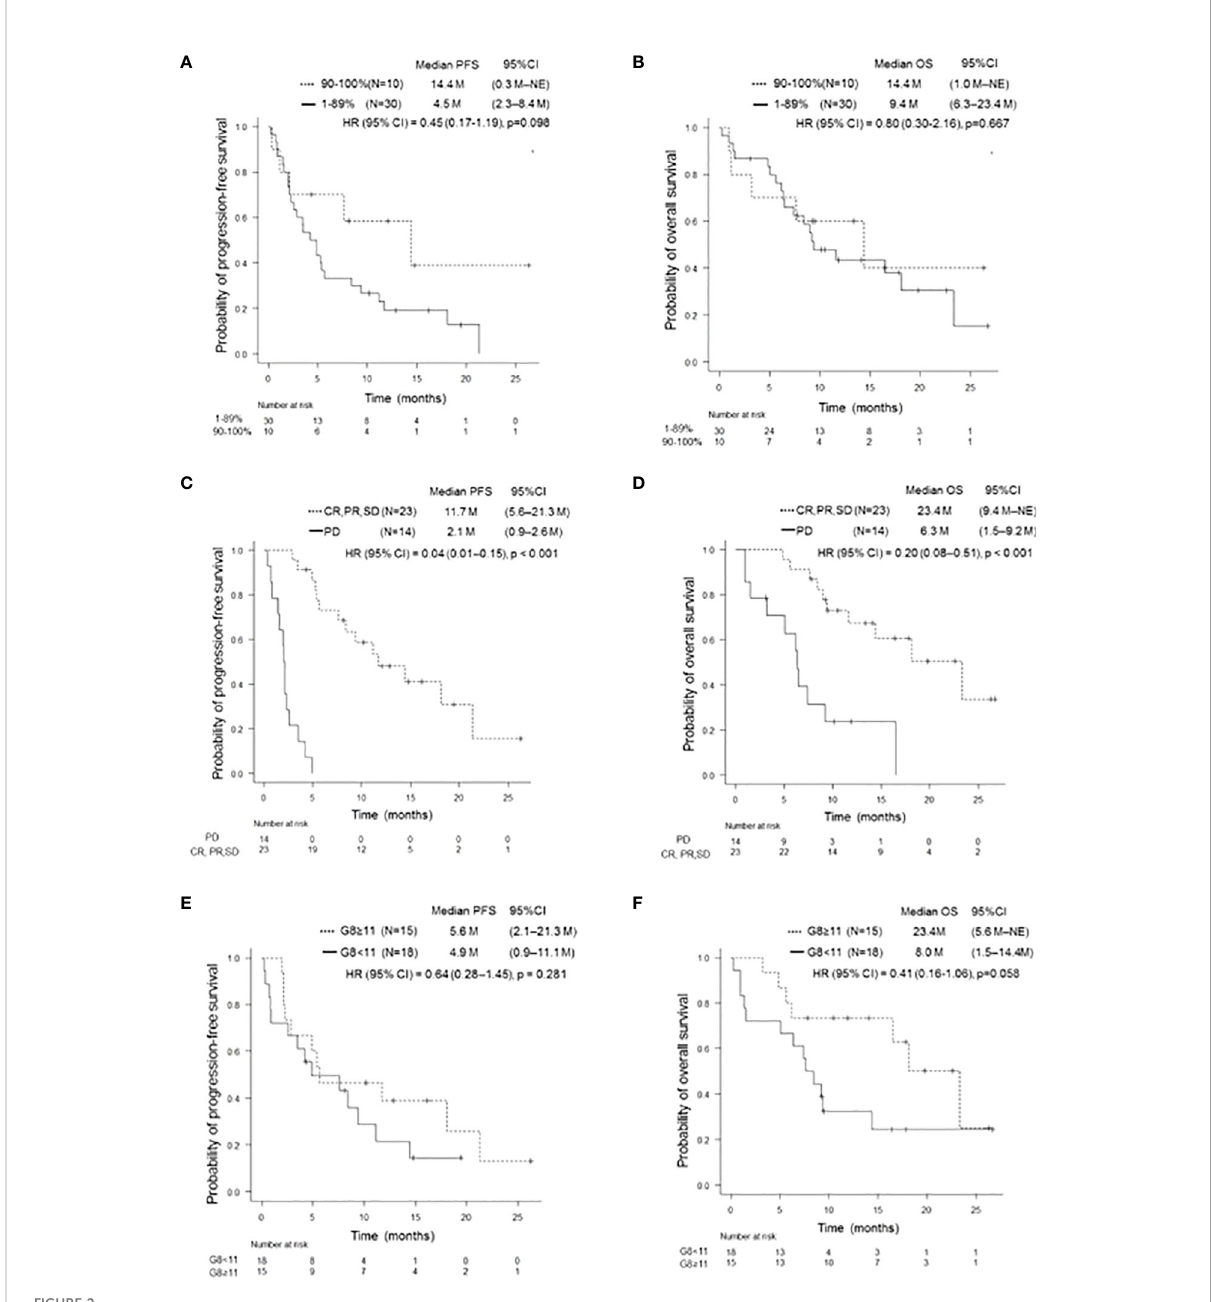
FIGURE 2 Kaplan-Meier survival curves for PFS and OS according to several clinical features. PFS (A) and OS (B) of patients with PD-L1 TPS ≥ 90% and 1 – 89%, respectively. Patients with a PD-L1 TPS of ≥ 90% showed a trend of prolonged PFS compared to those with a PD-L1 TPS of 1 – 89% (p = 0.098). There was no signi fi cant difference in OS (p = 0.667). PFS, progression-free survival; OS, overall survival; PD-L1, programmed cell-death Ligand 1; TPS, tumor proportion score. PFS (C) and OS (D) of patients on and not on pembrolizumab treatment who achieved SD or better. Patients who achieved SD or better had signi fi cantly longer PFS and OS than those who did not (p < 0.001, p < 0.001). PFS, progression-free survival; OS, overall survival; SD, stable disease. PFS (E) and OS (F) of patients with and without G8 ≥ 11. There was no signi fi cant difference in PFS (p = 0.281). Patients with G8 ≥ 11 tended to have longer OS than those with G8 <11 (p = 0.058). PFS, progression-free survival; OS, overall survival; G8, geriatric 8 screening